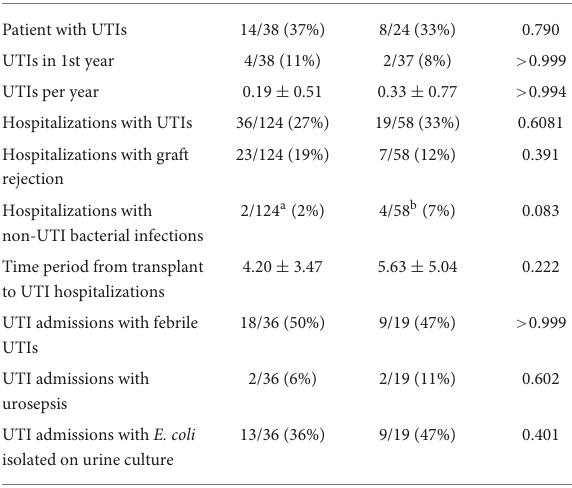
TABLE 2 Congenital anomalies of the kidney and urinary tract (CAKUT) vs. non-CAKUT, urinary tract infection (UTI) rates and